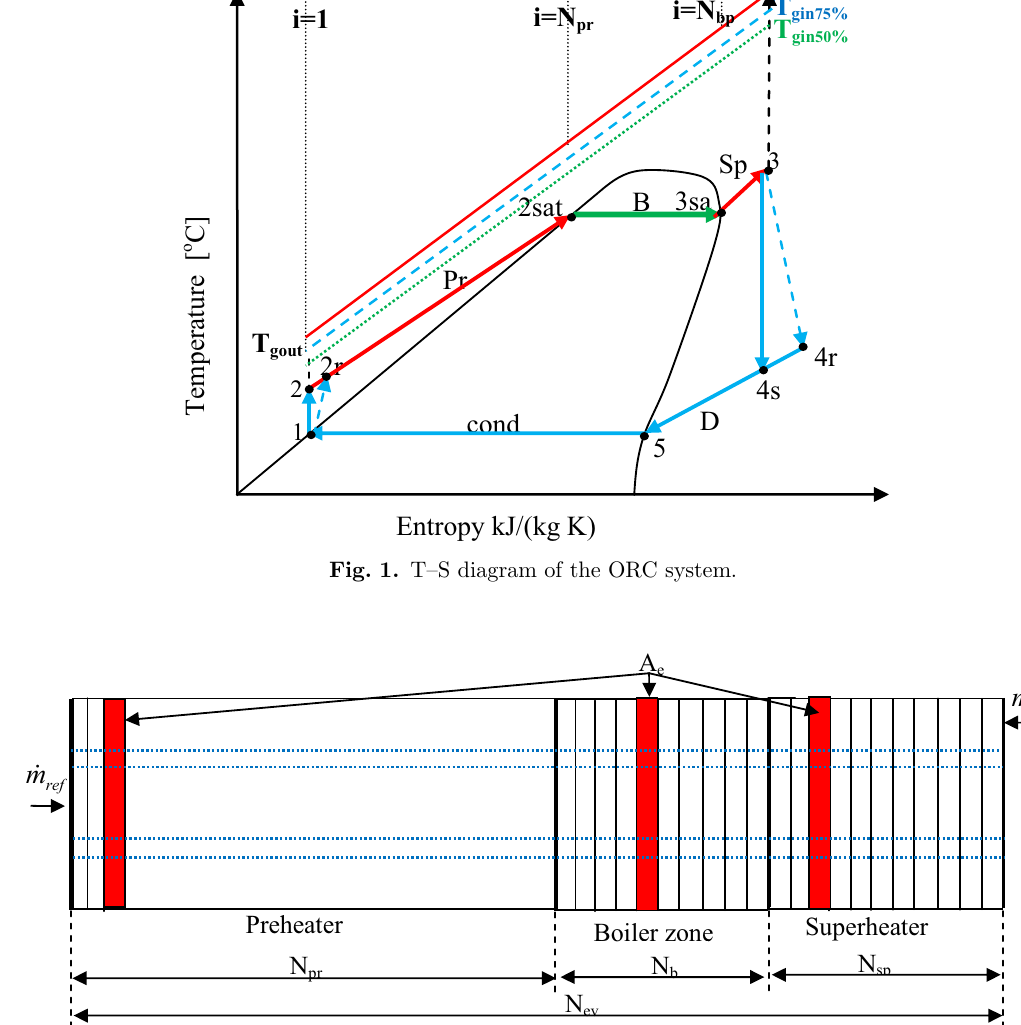
Fig. 2. Evaporator division